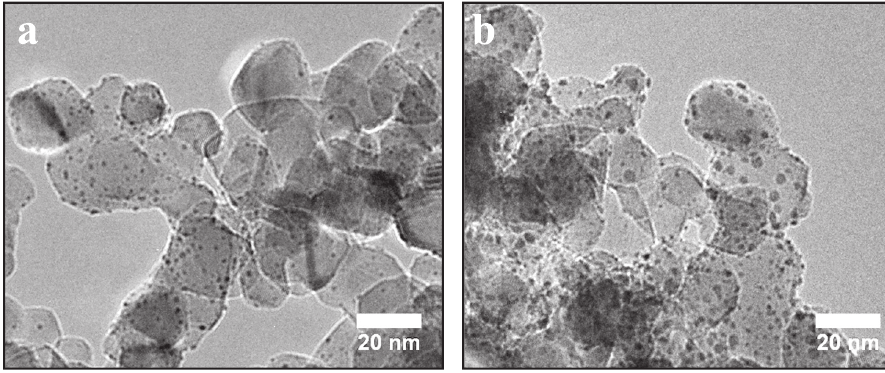
Fig. 10 Overview TEM images of Pt nanoclusters deposited on the TiO 2 support for 1 ALD cycle ( a ) and 5 ALD cycles ( b